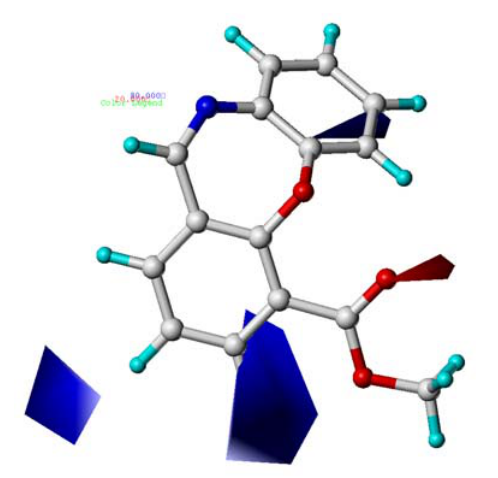
Figure 6. Contour maps of CoMSIA electrostatic region in combination with compound 10 . Electrostatic fields: blue contours (80% contribution) represent regions where low electron density groups increase activity, while red contours (20% contribution) represent regions where high electron density groups increase activity. Compound 10 is depicted in ball and stick representation, coloured by atom type (white C, blue N, red O, cyan